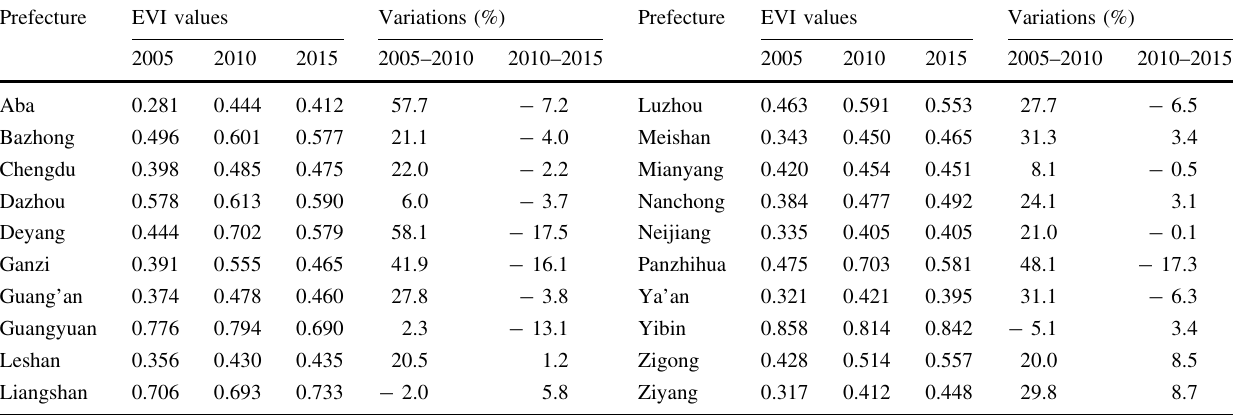
Table 3 Ecological vulnerability index (EVI) values of each prefecture in Sichuan Province, 2005, 2010, and 2015